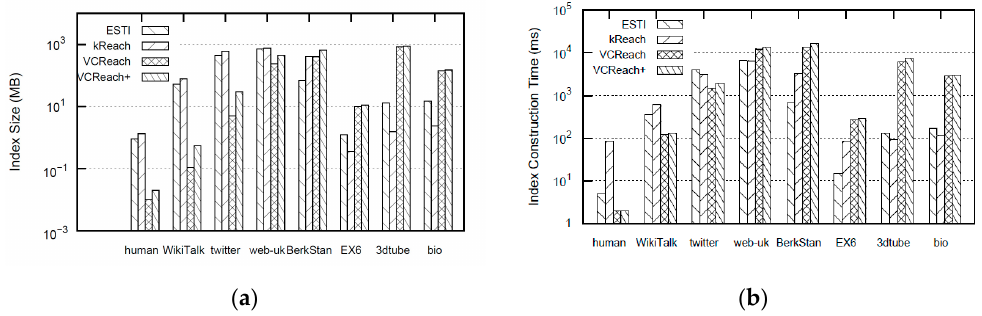
Figure 5. Comparison of index size and index construction time, where ( a ) shows comparison of index size (MB) and where ( b ) shows that of index construction time (ms).